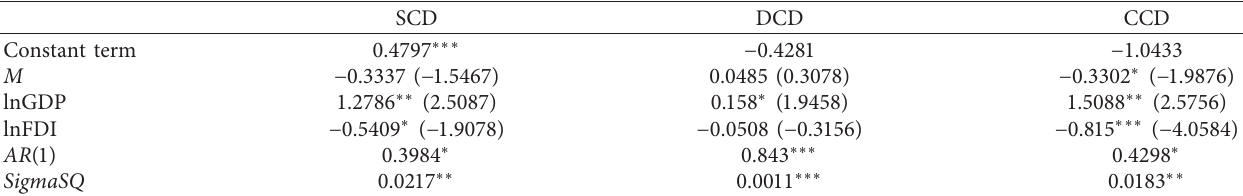
Table 3: Results of ARMA regression of marketization index and the coupling coordination